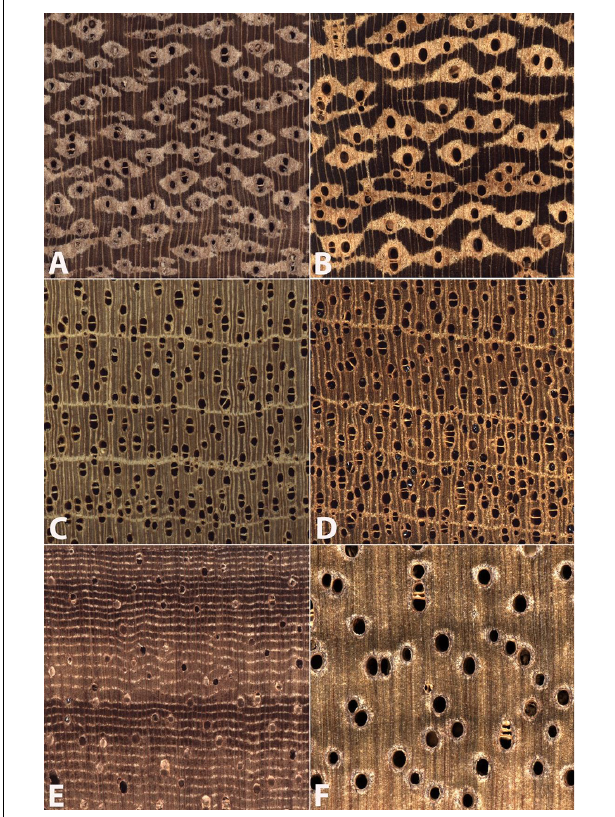
FIGURE 3 | Images of the transverse surface of test specimens (A,C,E) and exemplars of the class to which they were assigned (B,D,F) . All images are 6.35 mm on a side. An anatomically representative specimen of class Amburana (A) was misclassified as the anatomically similar class Ormosia (B) . An anatomically atypical specimen of class Virola (C) was classified as class Swietenia (D) . An anatomically typical specimen of class Cariniana (E) was misclassified as the wood anatomically disparate class Cedrelinga (F) .